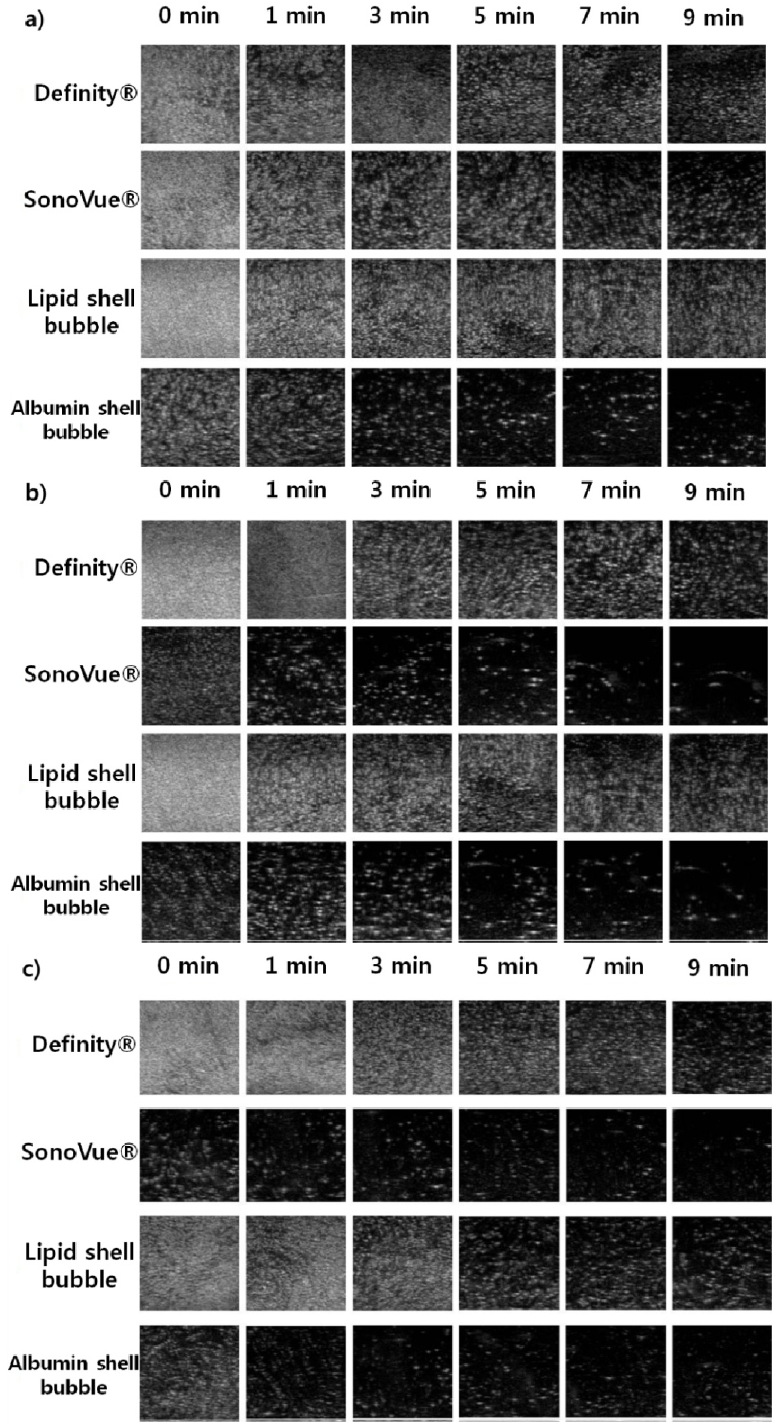
Figure 7. Ultrasound imaging comparison of two commercial UCAs and two synthesized UCAs over time (0, 1, 3, 5, 7, 9 min). ( a ) 3 days after synthesis. ( b ) 6 days after synthesis. ( c ) 9 days after synthesis. ( d ) 12 days after synthesis. ( e ) 15 days after synthesis. Ultrasound imaging results show that the synthesized microbubbles can be successfully used for imaging purposes. In particular, the synthesized lipid shell UCA shows almost equivalent imaging capabilities as Definity ® . On the other hand, the synthesized albumin shell UCA seems to less effective in increasing ultrasound imaging